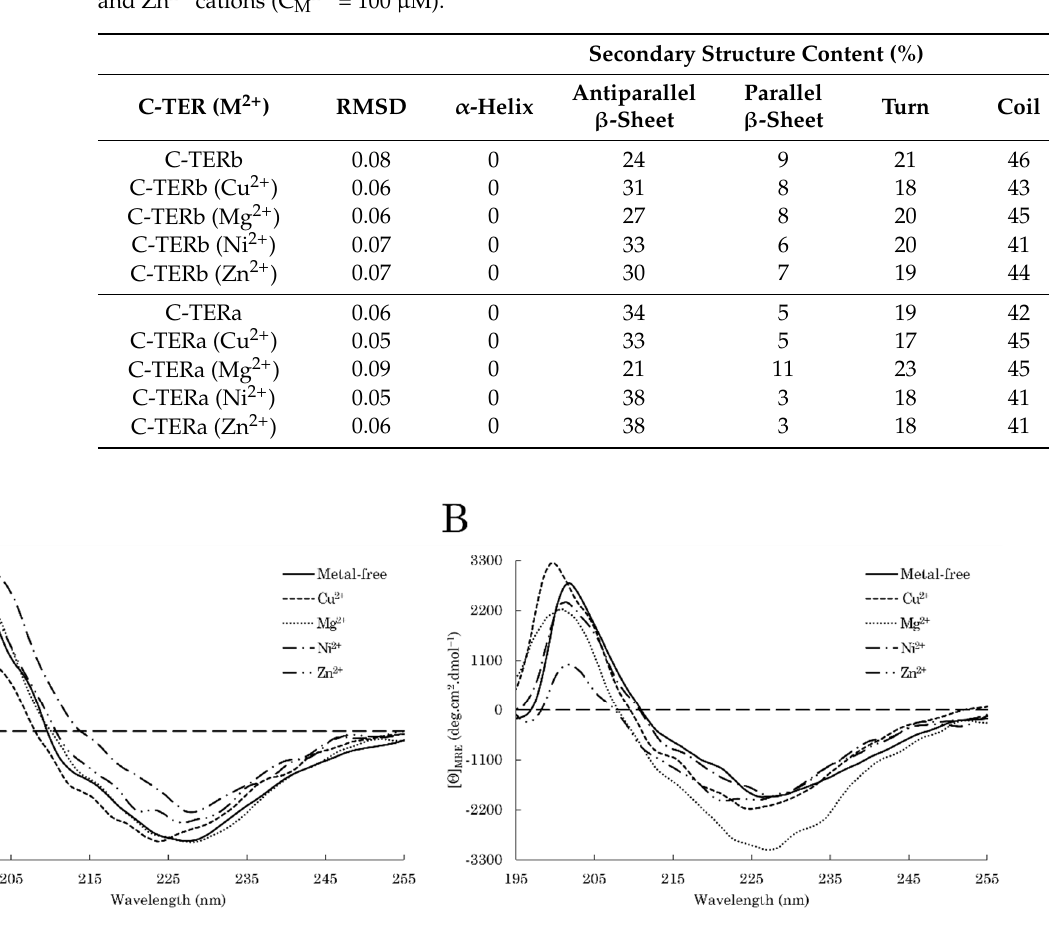
Figure 8. Far-UV CD spectra of ( A ) C-TERb and ( B ) C-TERa (C C-TER = 5 µ M) incubated in TBS at ~20 ◦ C for 72 h without metal (solid line) and in the presence of Cu 2+ (dashed line), Mg 2+ (dotted line), Ni 2+ (dashed-dotted line), and Zn 2+ (dashed-double-dotted line) cations (C M2+ = 100 µ M). Table 2. BeStSel secondary structure content estimations and fit ‐ associated RMSD values of C ‐ TERb and C ‐ TERa (C C ‐ TER = 5 μ M) incubated in TBS at ~20 °C for 72 h in the presence of Cu 2+ , Mg 2+ , Ni 2+ , and Zn 2+ cations (C M2+ = 100 μ M).